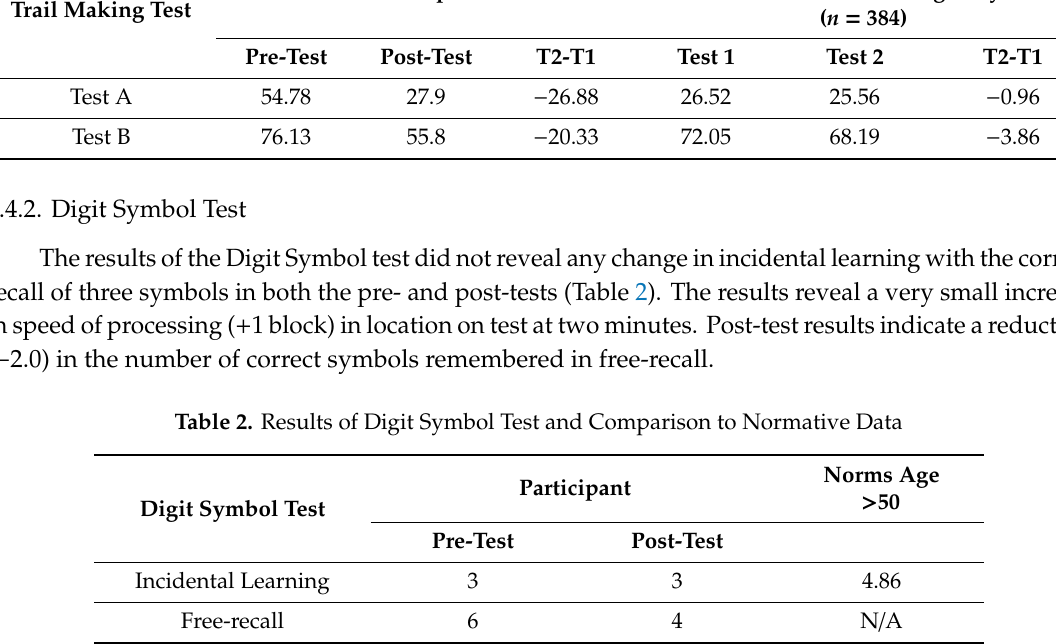
Trail Making Test